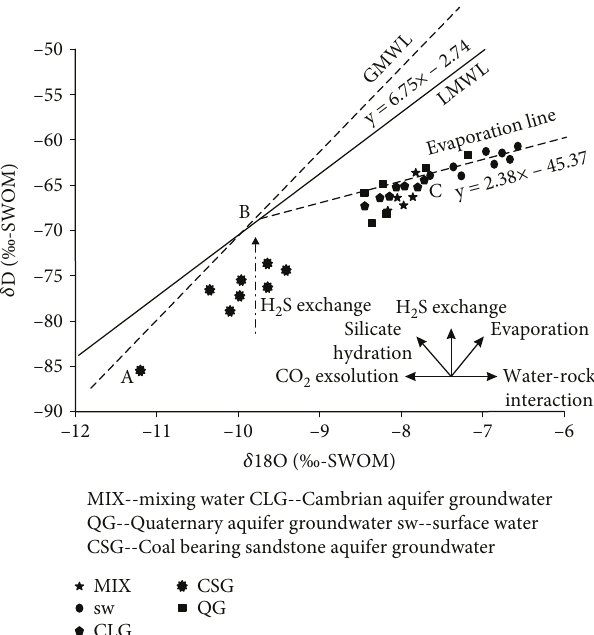
Figure 4: δ D – δ 18 O plot showing the stable isotope composition of water in the study area, which indicates the recharge sources. MIX: mixing water; CLG: Cambrian aquifer groundwater; QG: Quaternary aquifer groundwater; sw: surface water; CSG: coal- bearing sandstone aquifer groundwater. Figure 5: δ D – TDS and δ 18 O – TDS plots showing the increase in oxyhydrogen stable isotope ( δ value) of groundwater samples with the change in TDS. MIX: mixing water; CLG: Cambrian aquifer groundwater; QG: Quaternary aquifer groundwater; sw: surface water; CSG: coal-bearing sandstone aquifer groundwater.